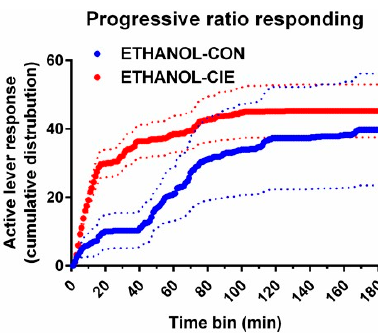
Figure 7. The ETHANOL-CIE group exhibited greater motivation for the ethanol reinforcer during protracted withdrawal compared with controls. This effect was reflected by a steeper rise in lever responding in the ETHANOL-CIE group (red) compared with the ETHANOL-CON group (blue). The data are expressed as the mean ± SEM for cumulative active lever responding that was emitted under the progressive-ratio schedule. n = 8/group.